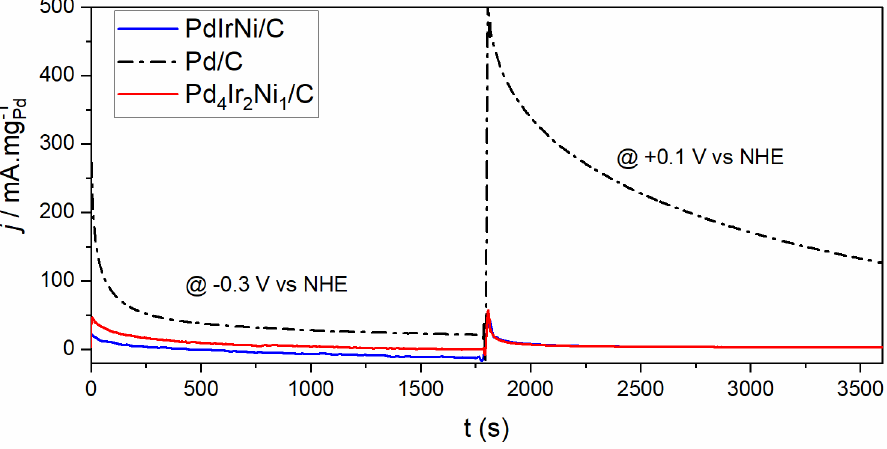
Figure 8. Step chronoamperometry (CA) scans of Pd/C Pd 4 Ir 2 Ni 1 /C and PdIrNi/C in 1M KOH + EtOH at −0.3 V and +0.1 V vs . NHE.